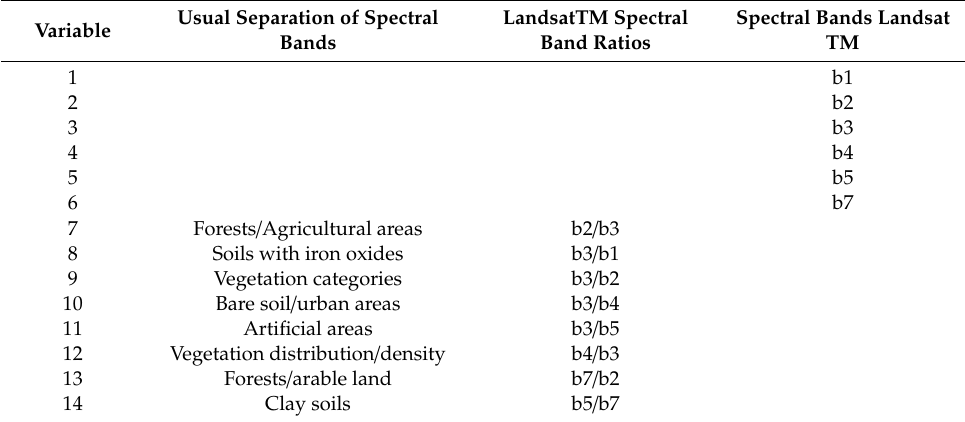
Table 3. Initial variables and spectral band ratios.